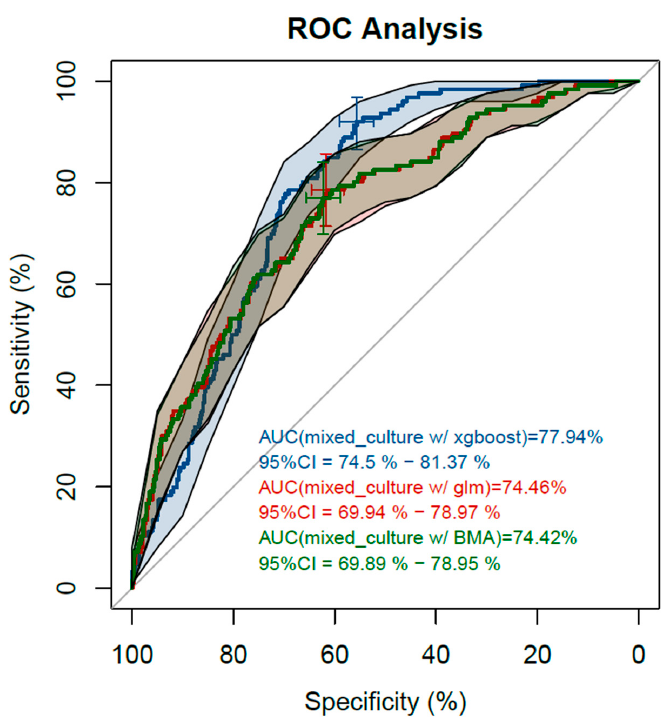
Figure 3. ROC with AUC and 95% CI. Blue curve: analysis using XGBoost with AUC 0.779 (95% CI: 0.745, 0.815). Red curve: analysis using glm with AUC 0.745 (95% CI: 0.699, 0.790). Green curve: analysis using BMA with AUC 0.744 (95% CI: 0.699, 0.790). AUC values ranging between 74.4% and 77.9% were achieved. Precision was <40% when recall was